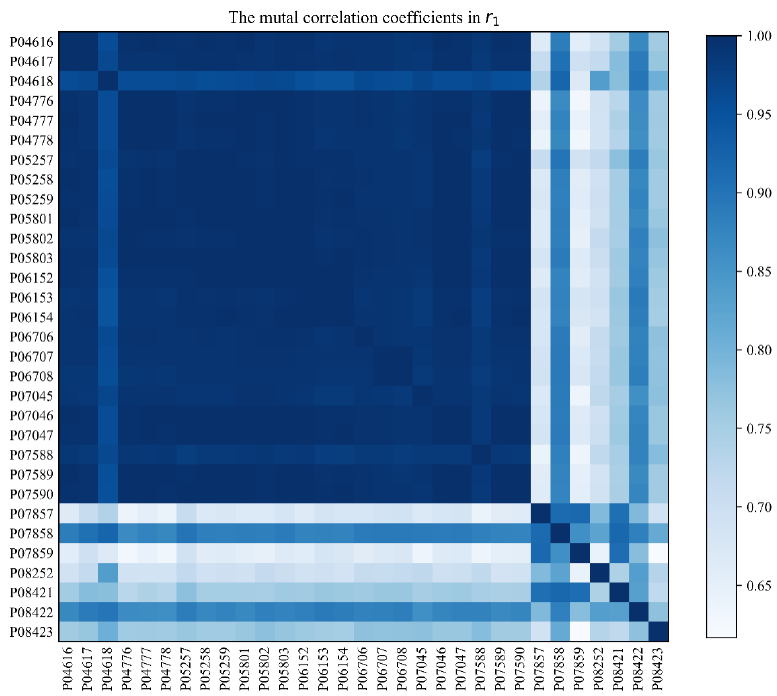
Figure 15. Correlation coefficients of all nodes available in single region r 1 .